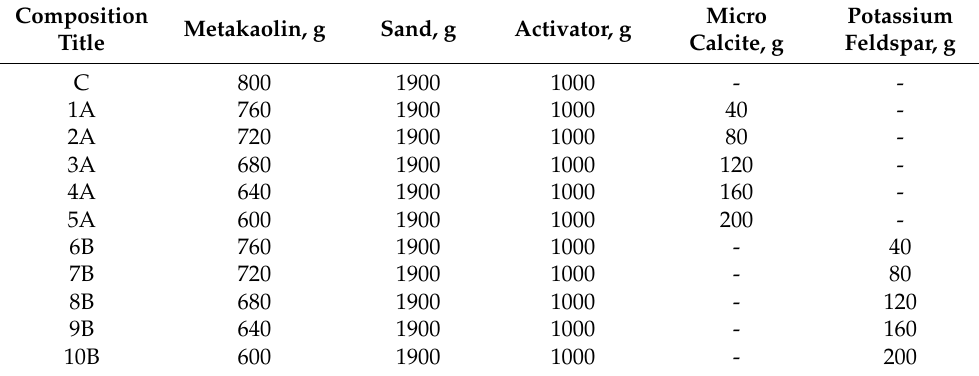
Table 7. Experimental compositions of geopolymer fine-grained concrete.